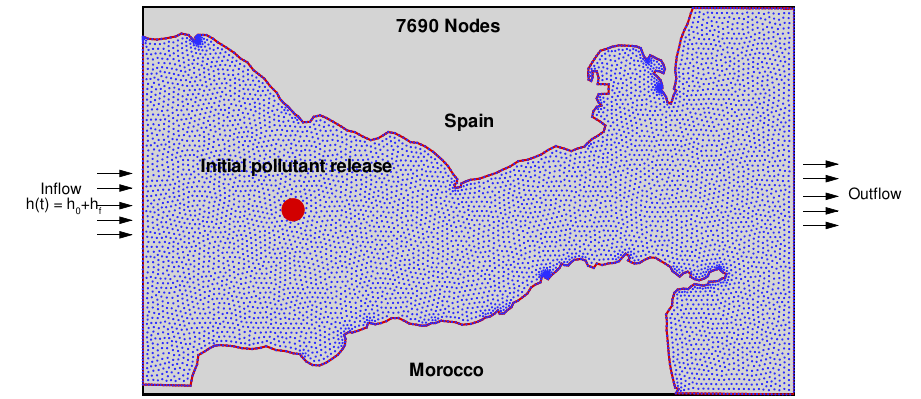
Figure 7. Computational nodes used for the Strait of Gibraltar simulations. Table 2. Numerical and physical parameters of the model. # of